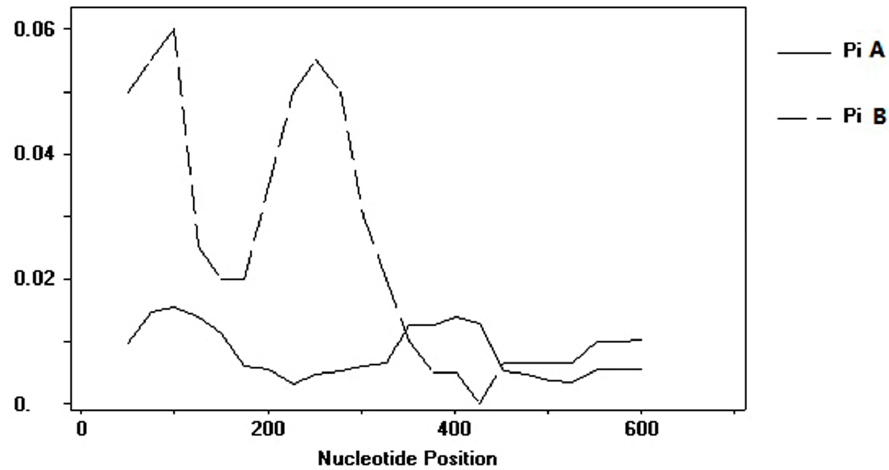
Figure 2. Nucleotide diversity in P1 virus genome. A window size of 100 bp and a step size of 25 bp were used. Group A is presented by broken lines, and B by straight lines.